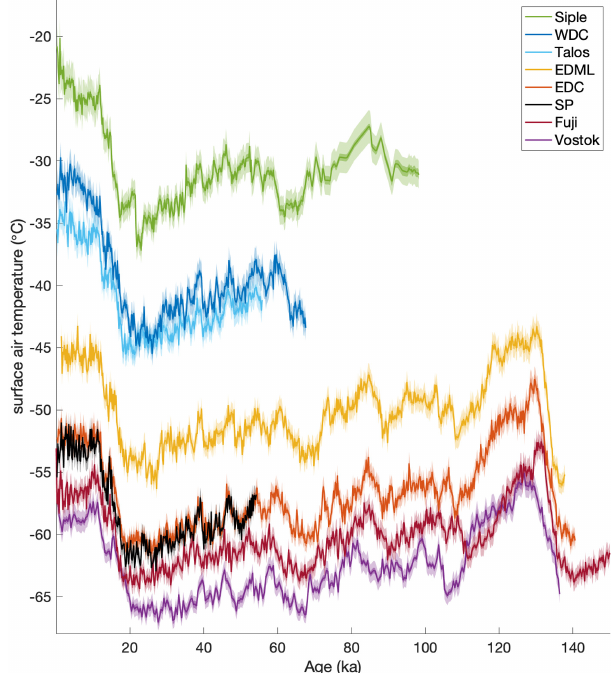
Figure A18. Condensation air temperature reconstruction for all ice-core sites. The light shading around the reconstructions repre- sents the uncertainty in absolute temperature, while the darker shad- ing represents the uncertainty in relative temperature variability as described in Sect. A9.